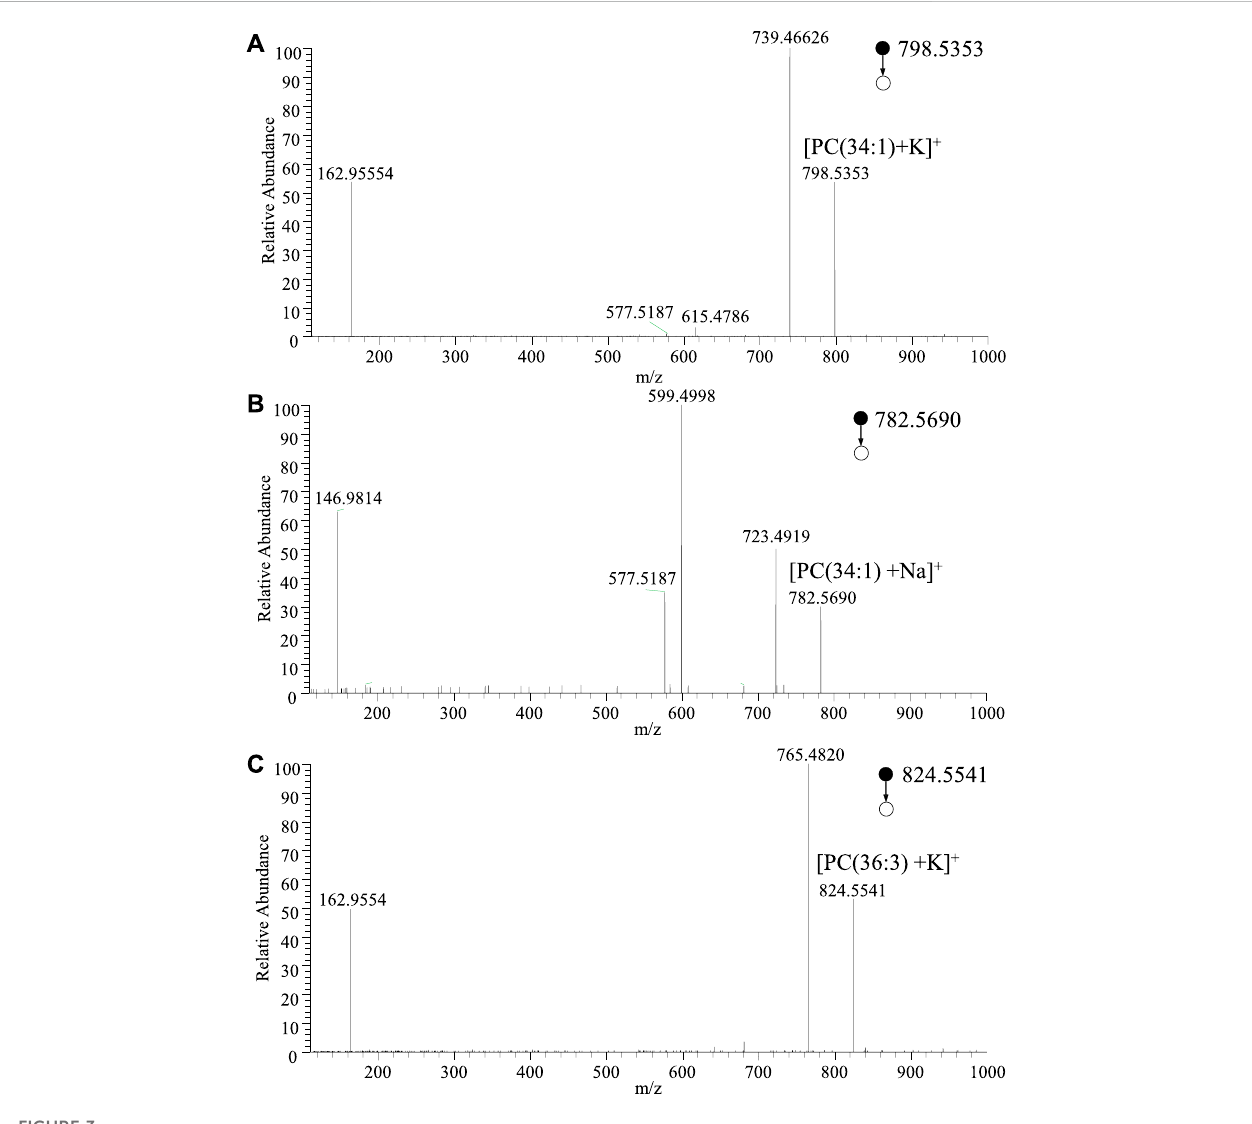
MS/MS spectra of adduct ions of typical lipids obtained by WT-ESI-MS: (A) [PC(34:1)+K] + , (B) [PC(34:1)+Na] + , (C) [PC(36:3)+K] + .